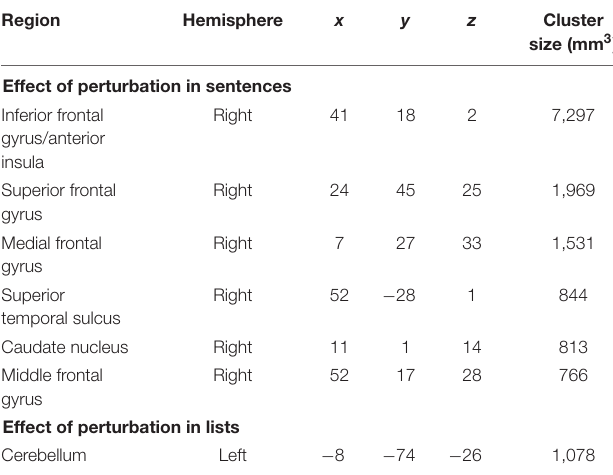
TABLE 2 | Effects of PERTURBATION